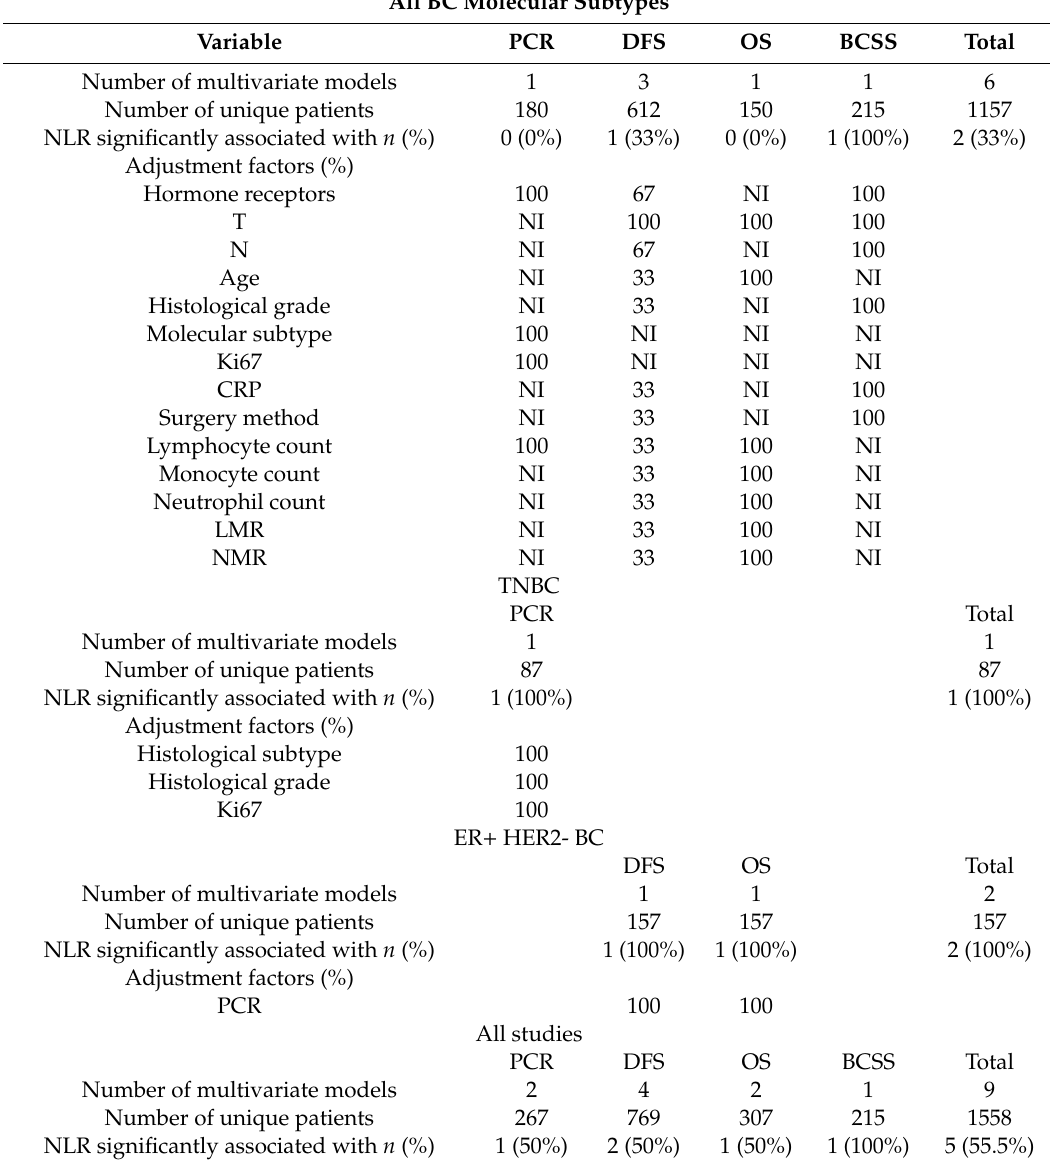
Number of multivariate models Number of unique patients NLR significantly associated with n